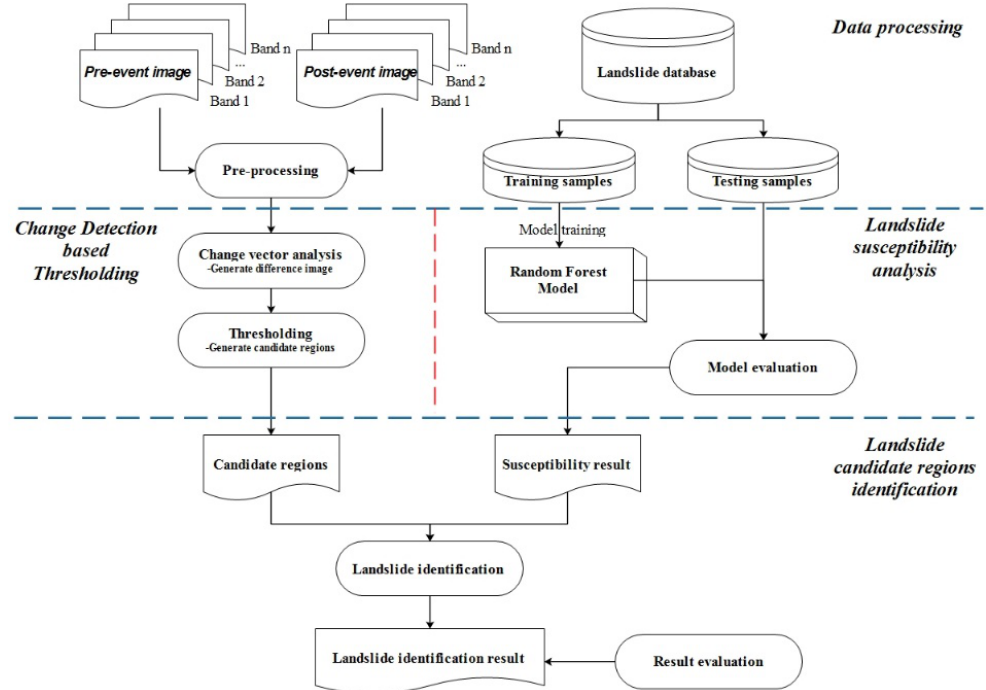
Figure 3. Flow chart of the proposed landslide identification method.